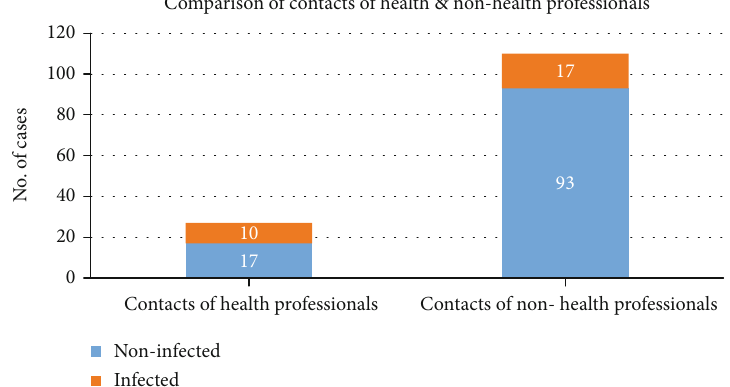
Figure 2: Comparison of contacts of the health and nonhealth professionals. Higher number of contacts of the health professionals developed symptoms ( p = 0 : 01 ) representing health professionals as index cases being a risk factor for transmission of COVID-19 to paediatric contacts.